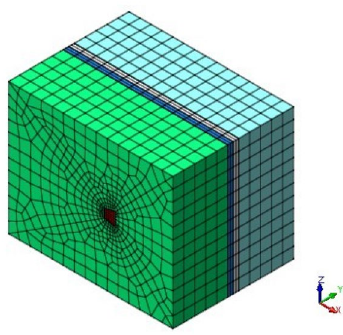
1500 mm ) and Anchor Pier Height L m ( 600 −